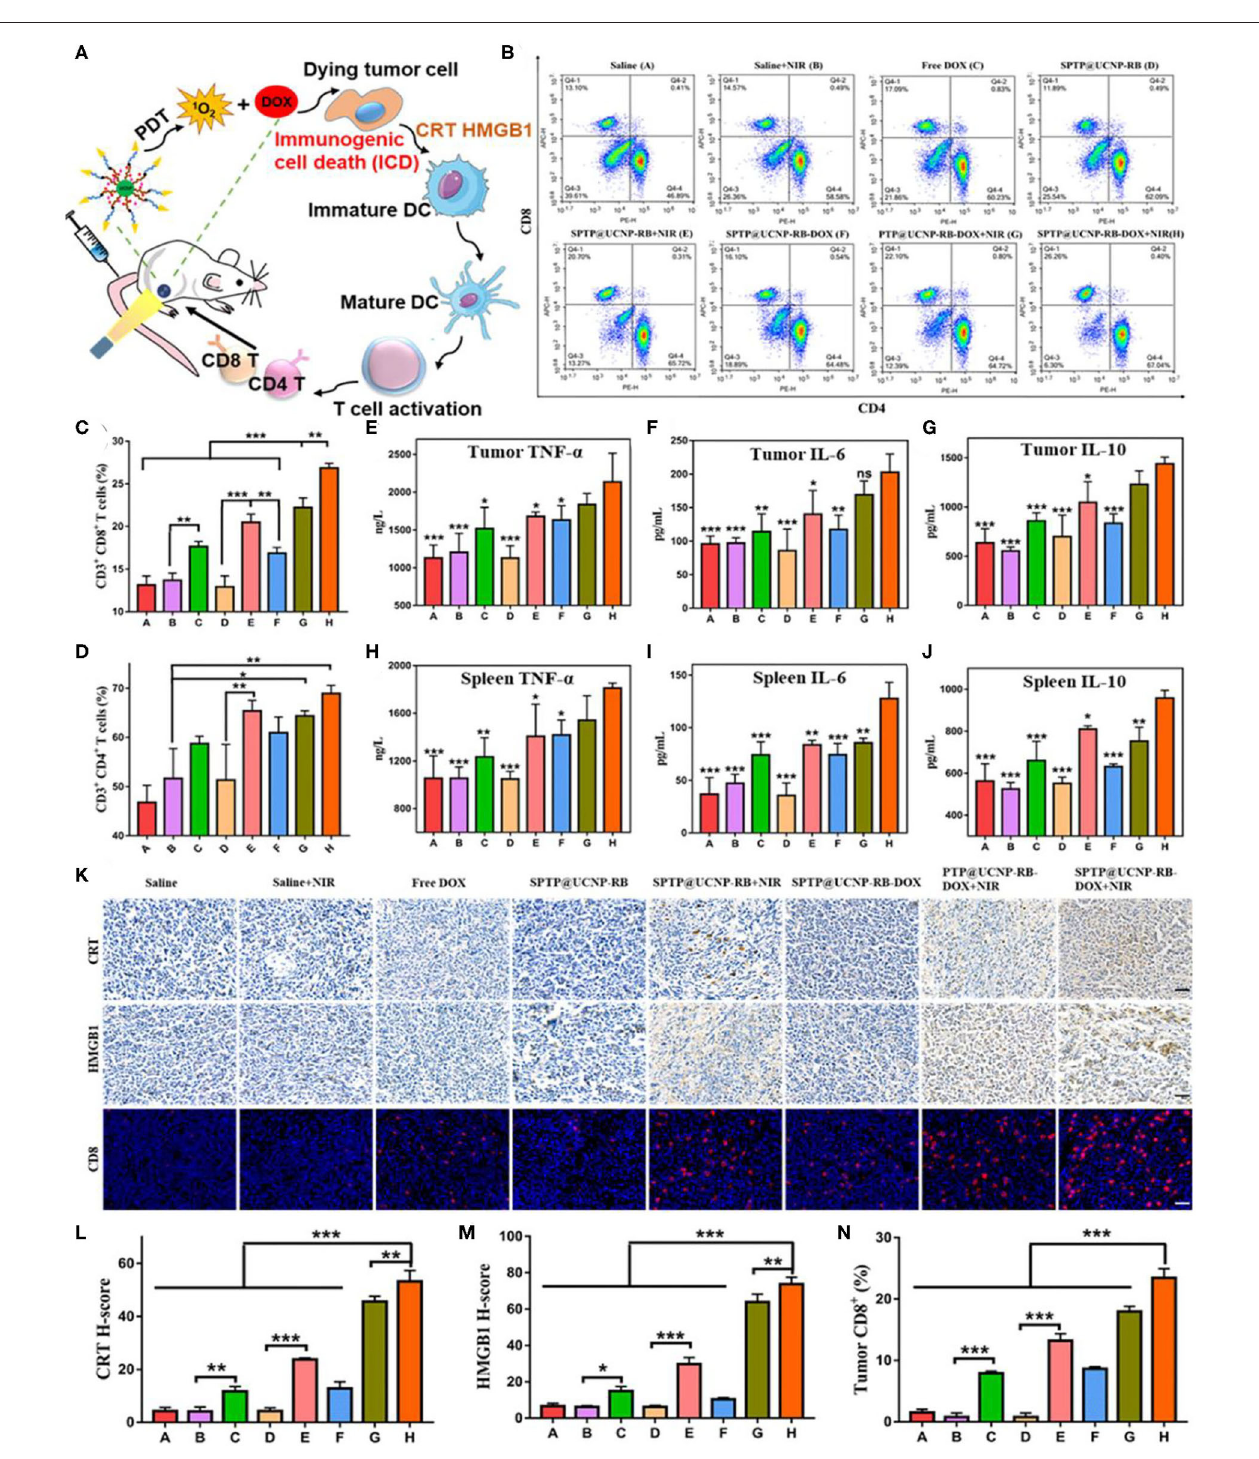
FIGURE 4 | Detection of antitumor immunity in vivo . (A) Illustration of the ICD-associated DAMP process. (B–D) Flow cytometry analysis of CD4 + T cells (CD3 + CD4 + ) and CD8 + T cells (CD3 + CD8 + ) proliferation in spleen tissues collected from all mice groups. (E–G) Quantitative analysis of TNF- α , IL-6, and IL-10 from tumor lysis solution and (H–J) in spleen lysis solution by the Elisa kit. Symbols on columns represent statistic difference vs. the SPTP@UCNP-RB-DOX + NIR group ( n = 6). (K) CRT exposure and HMGB1 secretion in tumor tissues were observed by immunohistochemistry. The infiltration of immune cells in tumors was detected by immunofluorescence dyeing of CD8T cells (scale bar = 20 µ m). (L–N) Quantitative analysis of CRT exposure, HMGB1 secretion, and CD8 infiltration in tumor tissues by image J. * p < 0.05; ** p < 0.01; *** p < 0.001. Copyright 2020, American Chemical Society (Jin et al., 2020).